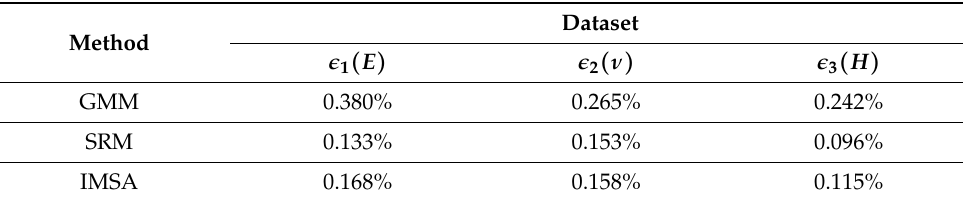
Table 2. The average relative error estimated for the three methods via the application to the synthesized